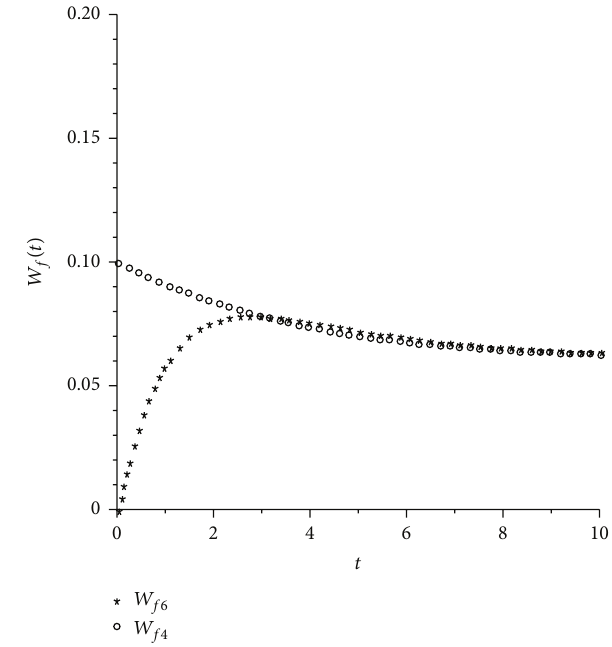
Figure 8: Instantaneous failure frequencies of the systems with and without warning device with 𝛼 = 1 .